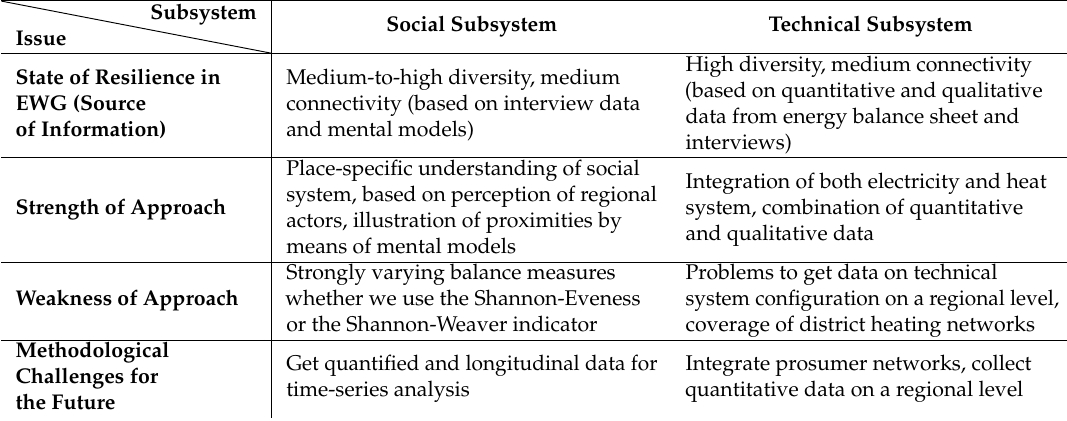
Table 6. Key insights from the analysis of the technical and social subsystem in